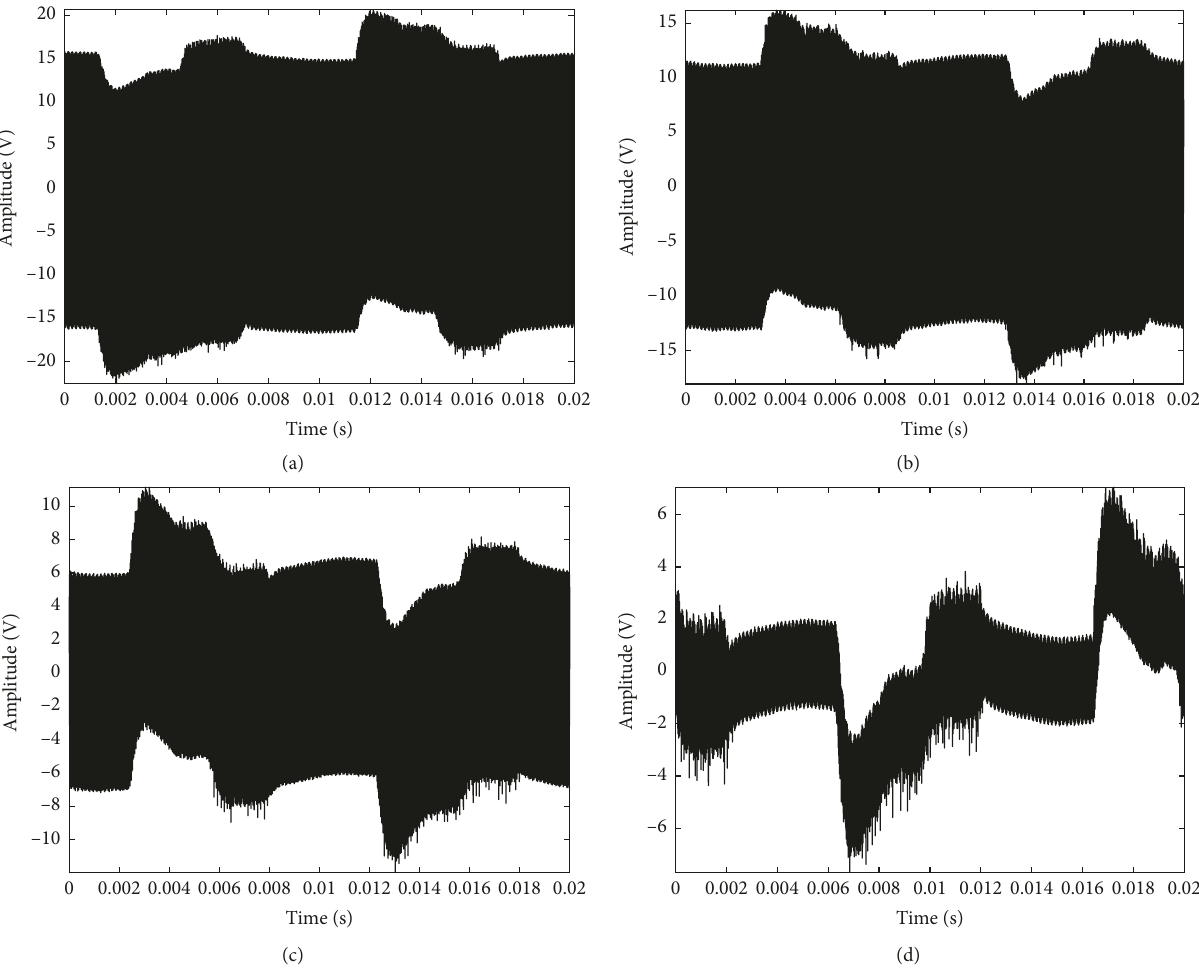
Figure 4: The waveform of MEV in four degradation states: (a) normal state; (b) slight degradation; (c) severe degradation; (d) failure state.